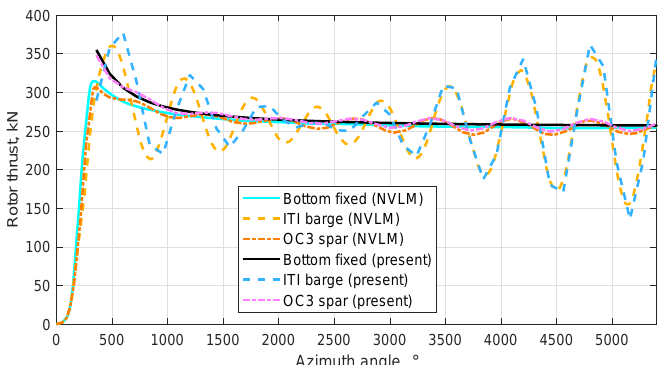
Figure 13. Variation in the thrust of 5 MW NREL wind turbine in multiple-DoF